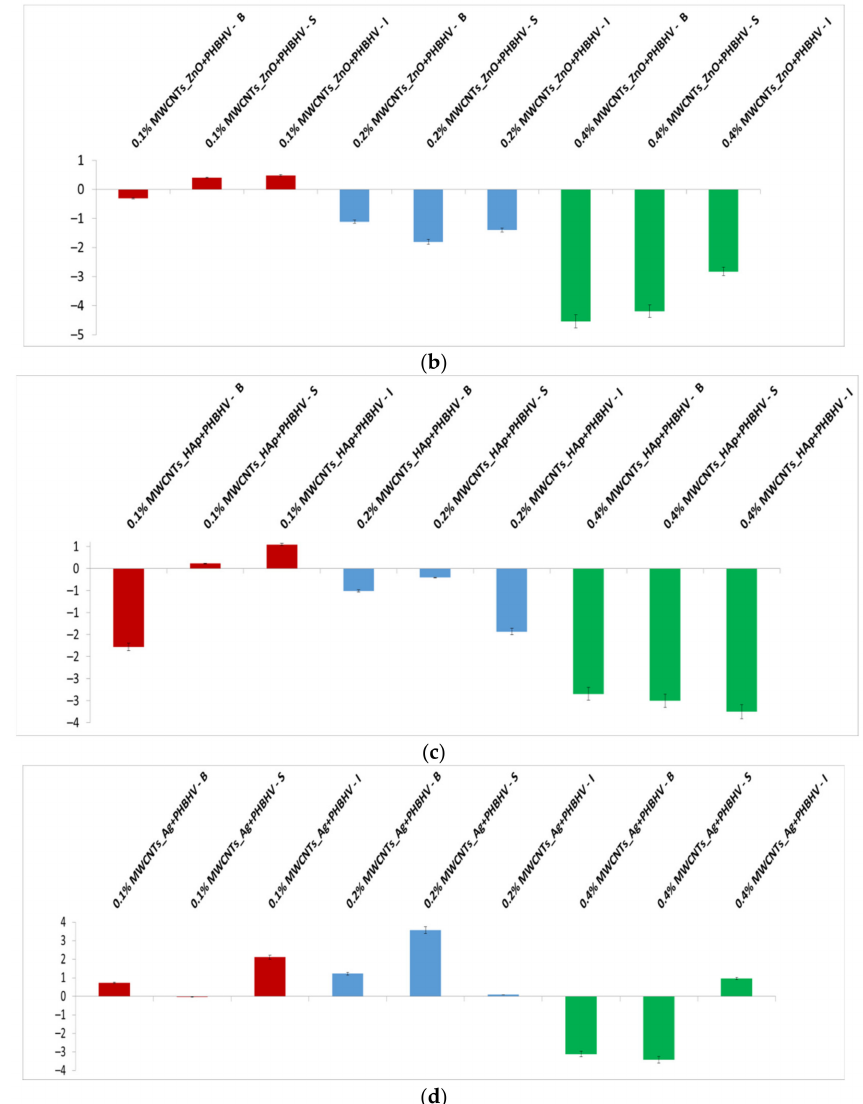
Figure 3. Calculated lightness difference ( ∆ L x ): ( a ) MWCNTs + PHBHV set, ( b ) MWC- NTs_ZnO + PHBHV set, ( c ) MWCNTs_HAp + PHBHV set and ( d ) MWCNTs_Ag + PHBHV set. The results are presented as the mean ± S.D. of three